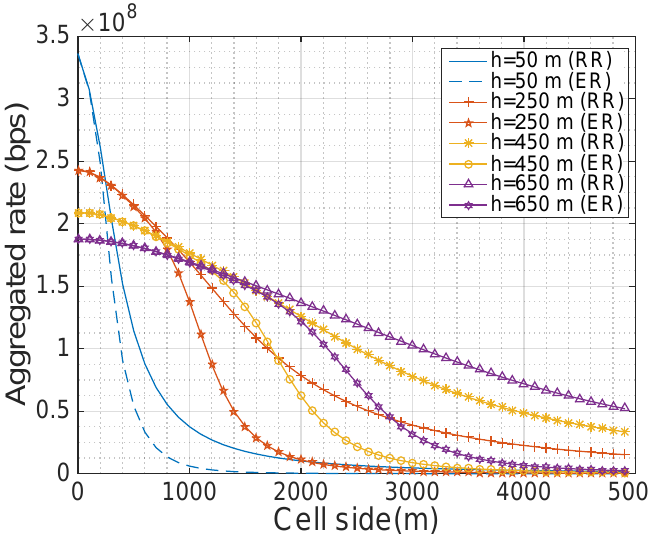
Figure 2. Aggregated rate of the round robin (RR) and the equal rate (ER) schedulers as a function of the cell